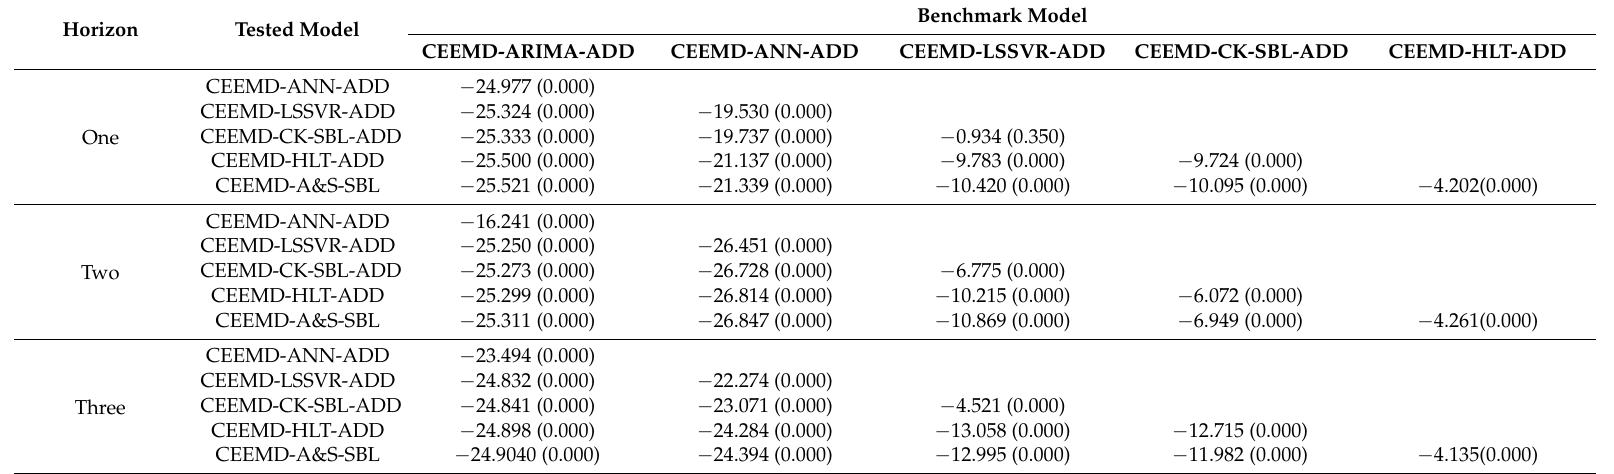
Table 7. The Diebold–Mariano (DM) test results on Brent crude oil